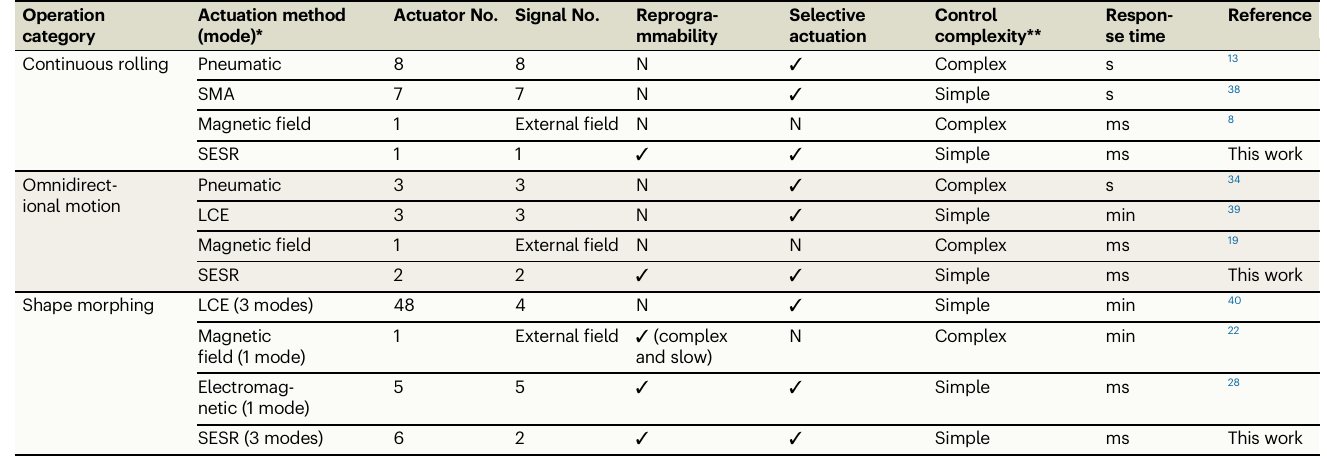
Table 1 | Comparison of different soft actuators and robots on fl exibility and operational dimensionality Operation